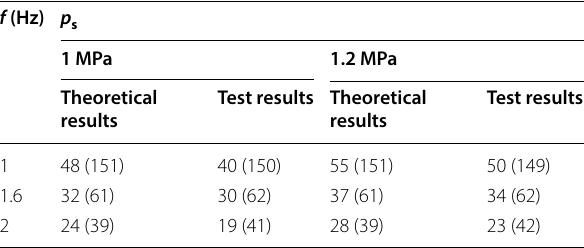
Table 6 Main comparison between theoretical and test values of a ( L ) ( x 1 mm) (mm) 0max v =